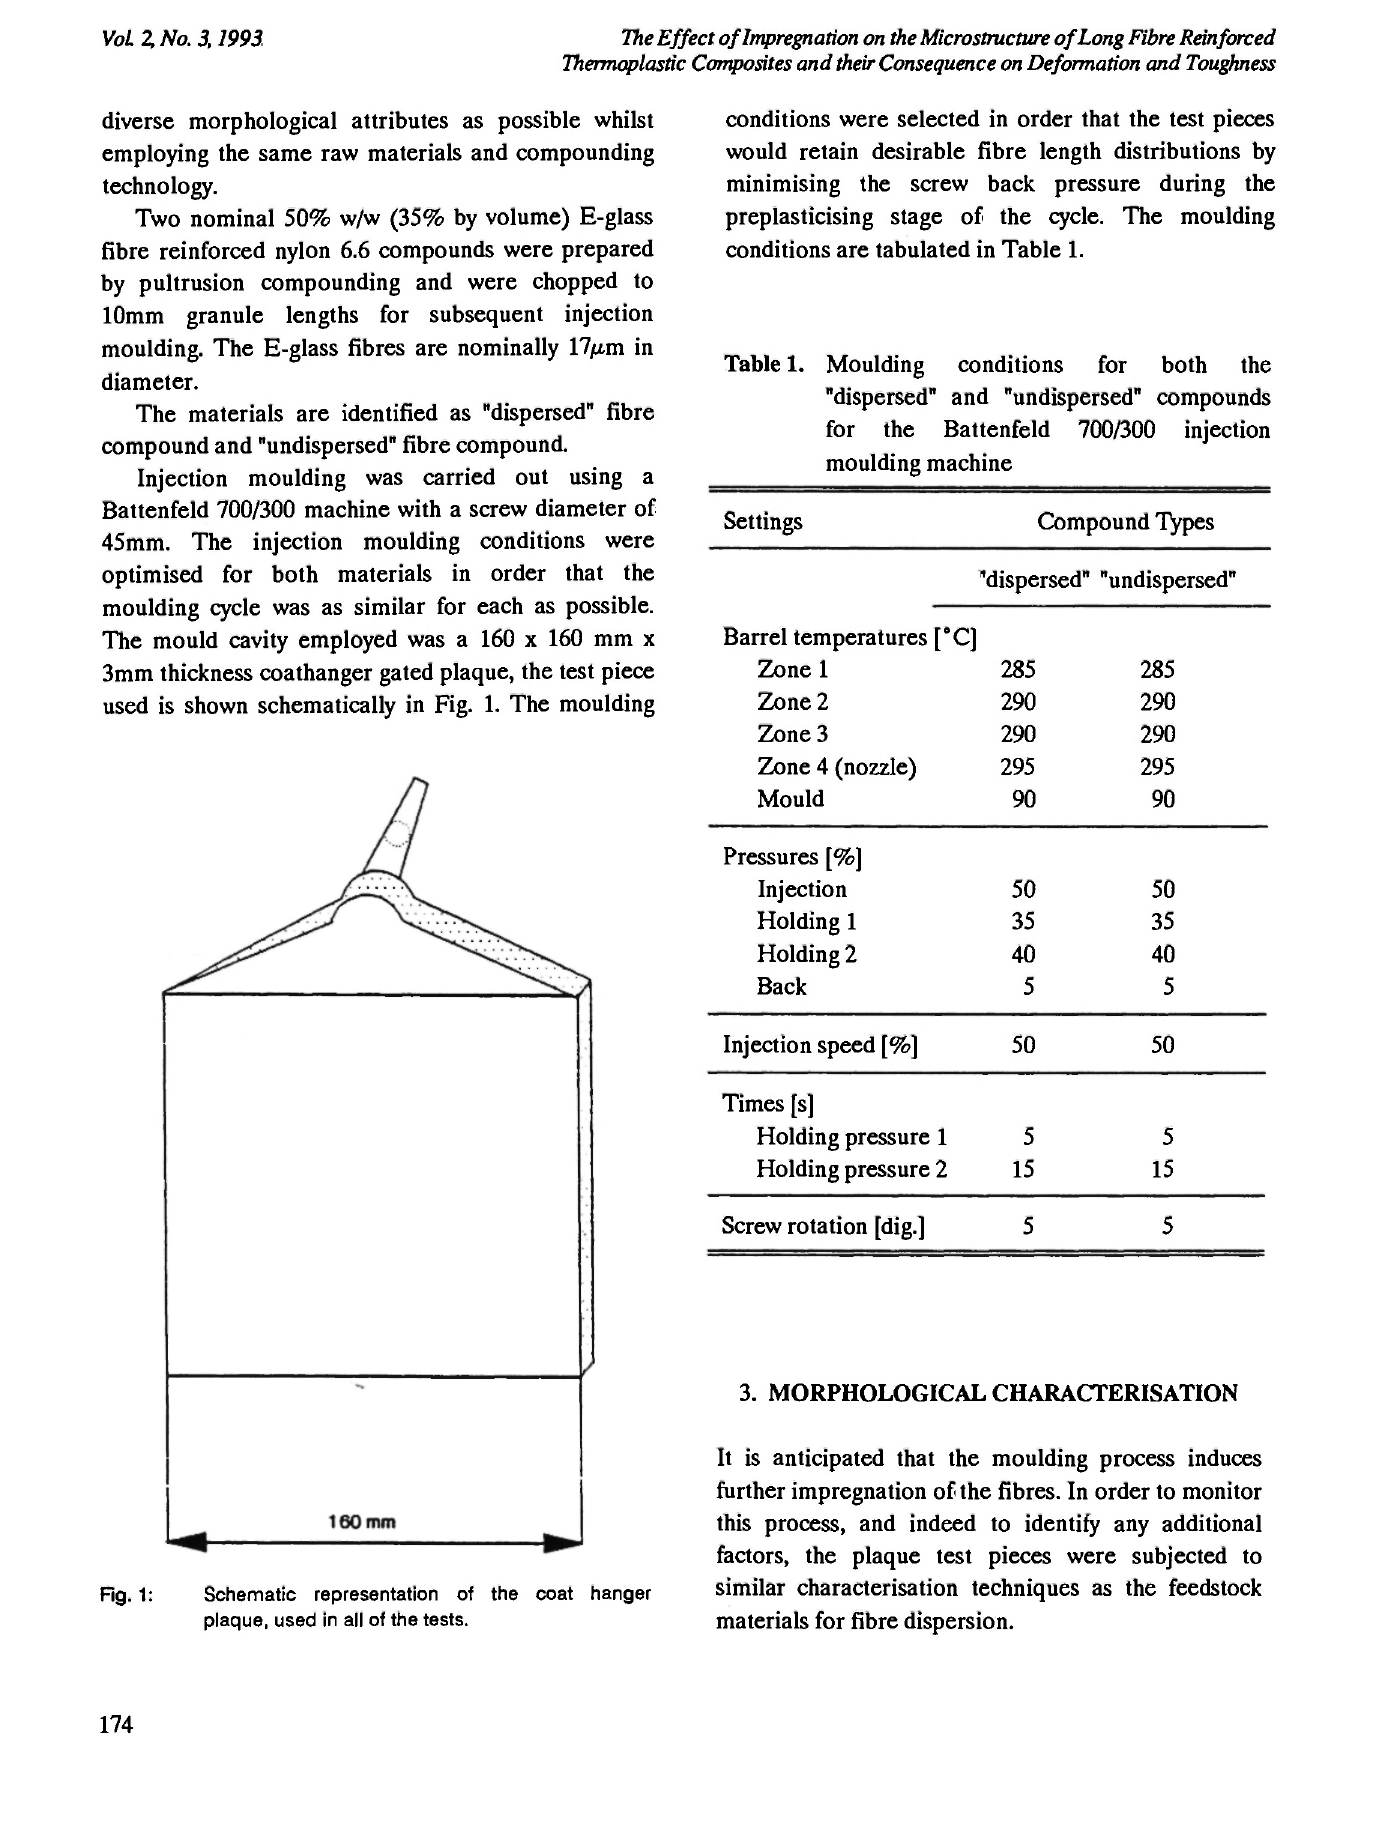
Fig. 1: Schematic representation of the coat hanger plaque, used in all of the